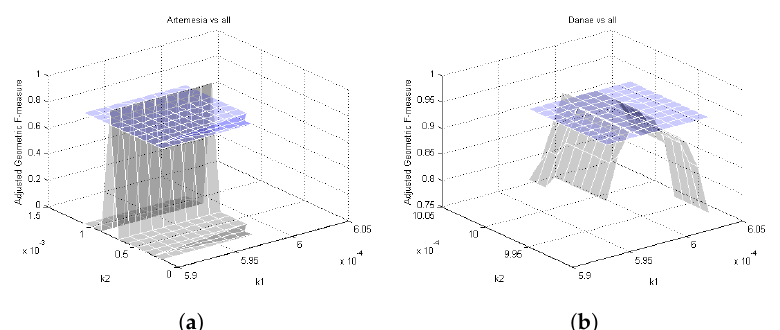
Figure 6. Parameter Choice 1. The x and y axes represent the values of the parameters of the two methods, while on the z axis is plotted the Adjusted F-measure (AGF) for two of the OvA configurations of the dataset in [26]: ( a ) Artemisia vs. all and ( b ) Danae vs. all. The gray and blue surfaces represent, respectively, the results with the Asymmetric Kernel Scaling (AKS) and SVM classifiers.